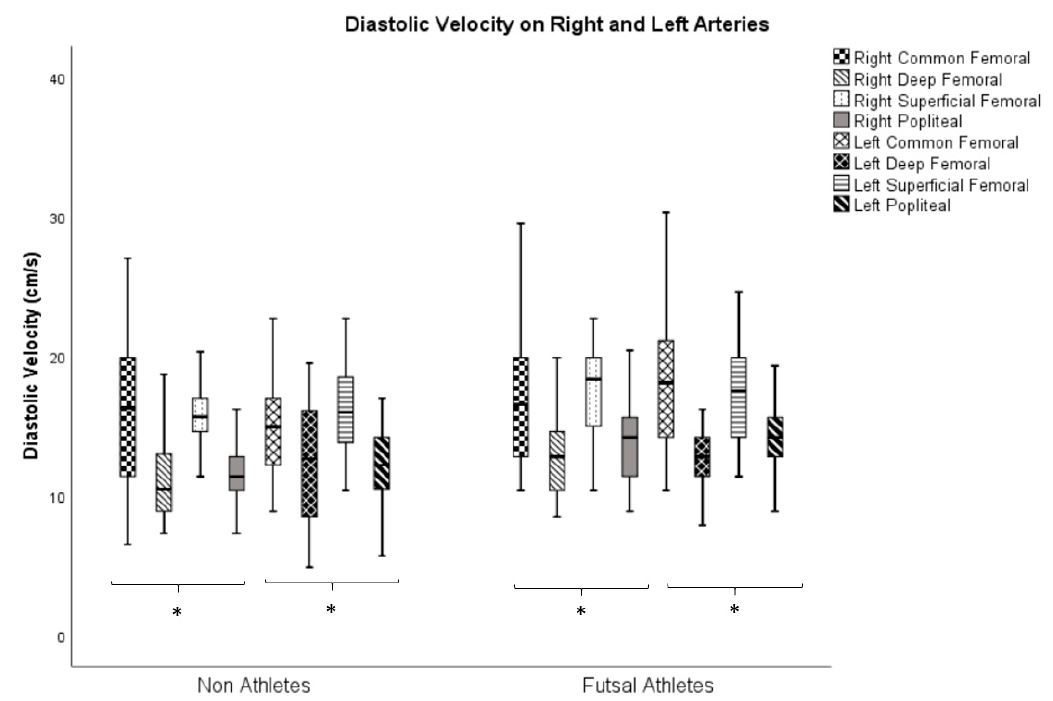
Figure 4. Analysis of the variance of diastolic velocities on right and left arteries in non-athletes and futsal athletes (* p ≤ 0.05—Friedman’s Test).